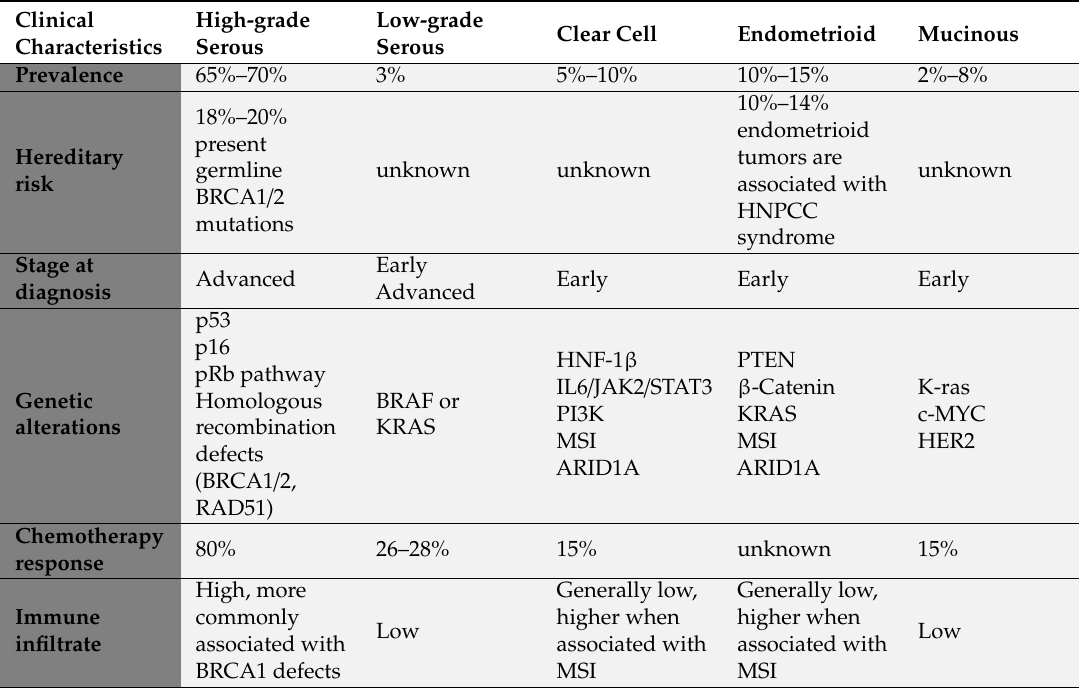
Table 1. Characteristics of di ff erent ovarian cancer histological